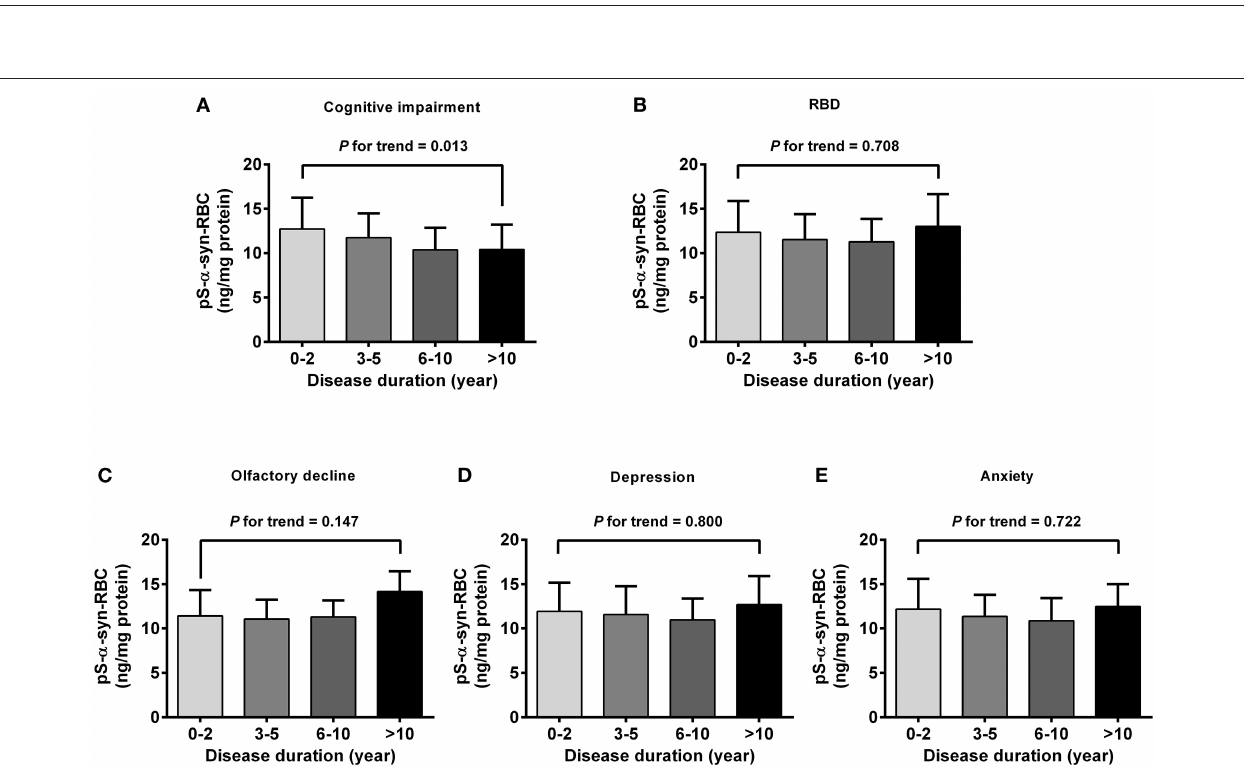
Frontiers in Aging Neuroscience |